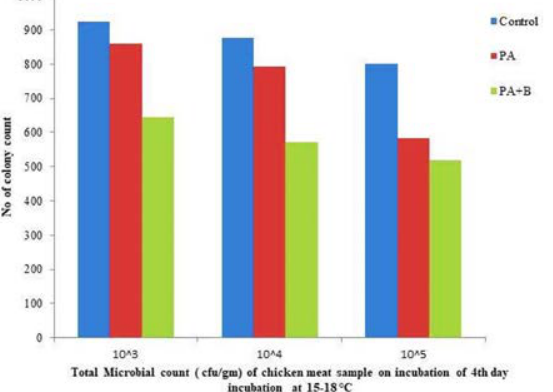
Fig. 2.3. Total microbial count of Chicken meat sample treated with strain and phage on 4 th day of Incubation at 15-18